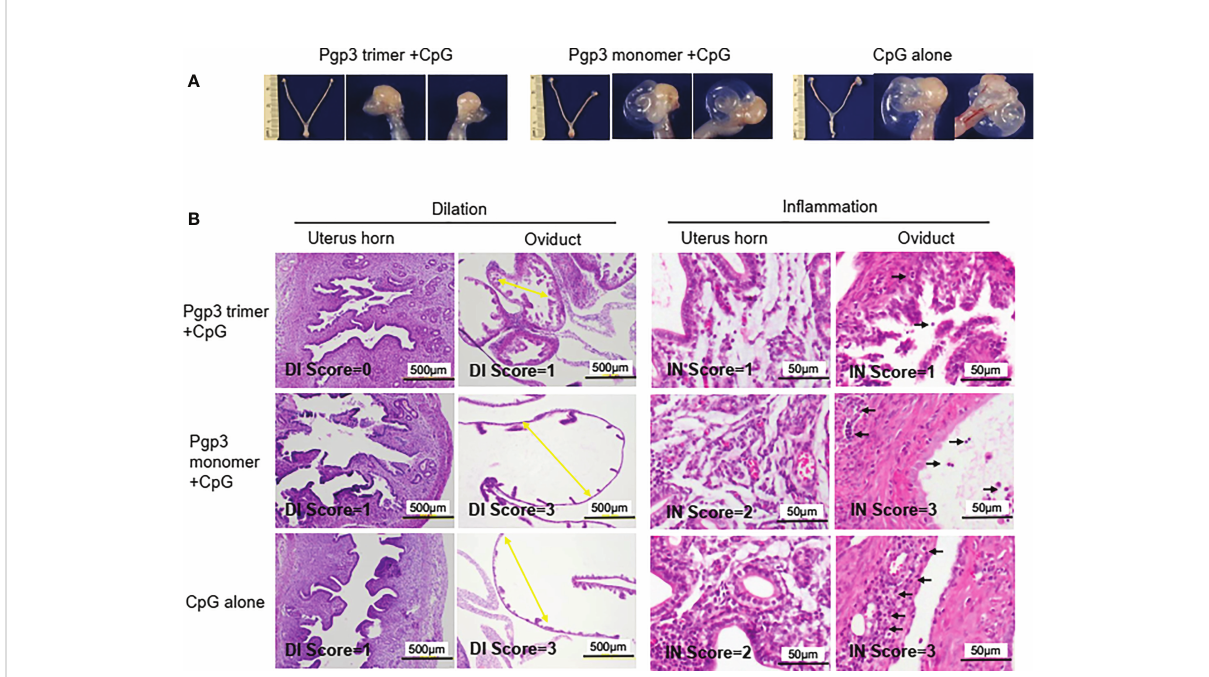
FIGURE 6 Pgp3 trimer immunization reduced C. muridarum -induced upper genital tract pathology. Sixty days after C. muridarum infection, mice were sacri fi ced for pathology observation. (A) The urogenital tract tissues from mice immunized with Pgp3 trimer + CpG, Pgp3 monomer + CpG or CpG alone were examined at the level of gross appearance. Representative images of the intact urogenital tract tissues and corresponding ampli fi ed oviduct/ovary from both left and right side were presented. (B) The urogenital tract tissues were sectioned for microscopic observation of histological pathologies. Representative images from each group containing the uterine horn or oviduct are shown. DI, luminal dilation (yellow arrow); IN, in fl ammatory cell in fi ltration (black arrow).